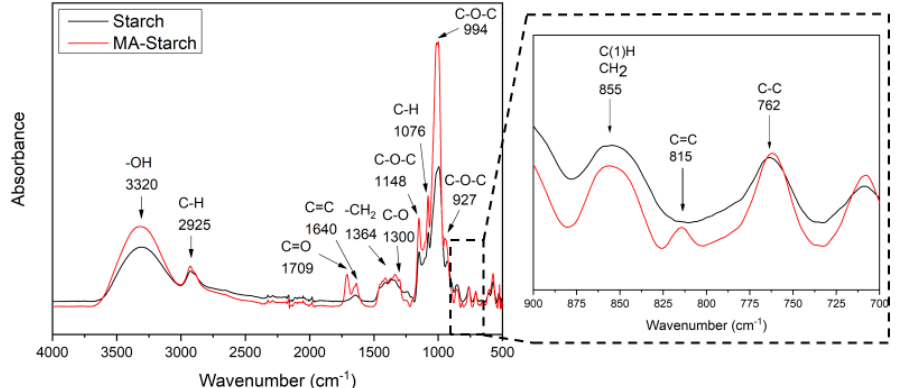
Figure 2. FTIR spectra of Starch-reference recorded before (black curve) and MA-Starch after the methacrylation reaction (red curve).